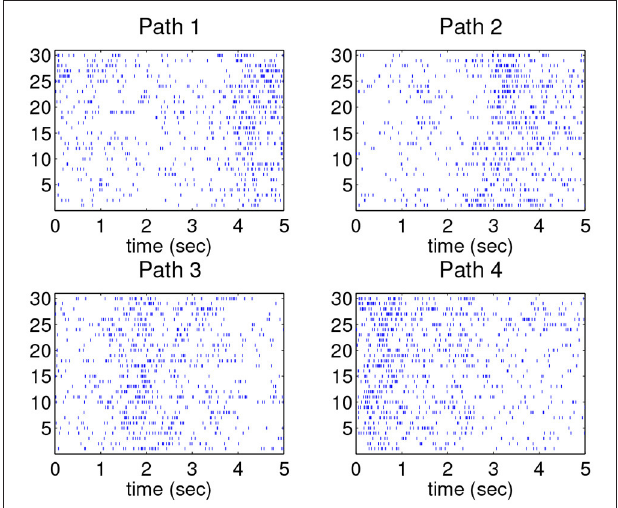
FIGURE 6 | 30 spike trains in each of the four movement paths.